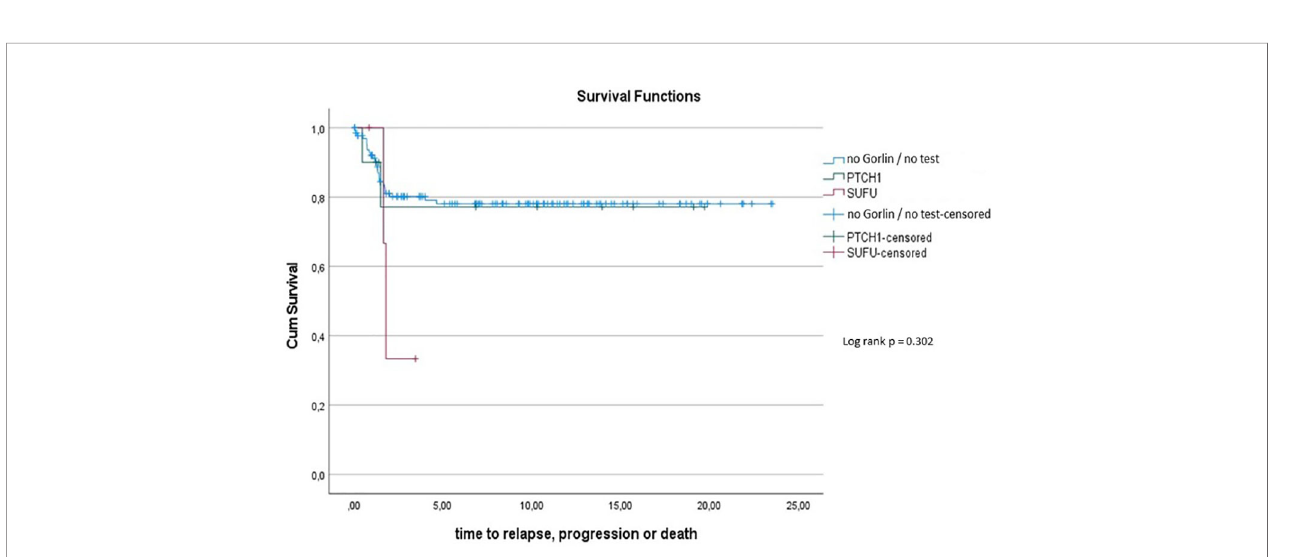
FIGURE 9 | PFS for all SHH+, MBEN/DMB <3.5 vs. PTCH1 vs. SUFU